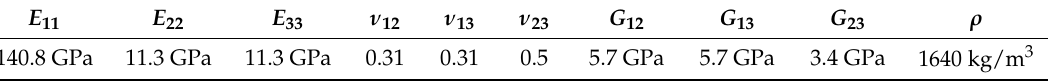
Table 1. Engineering constants of the unidirectional prepreg